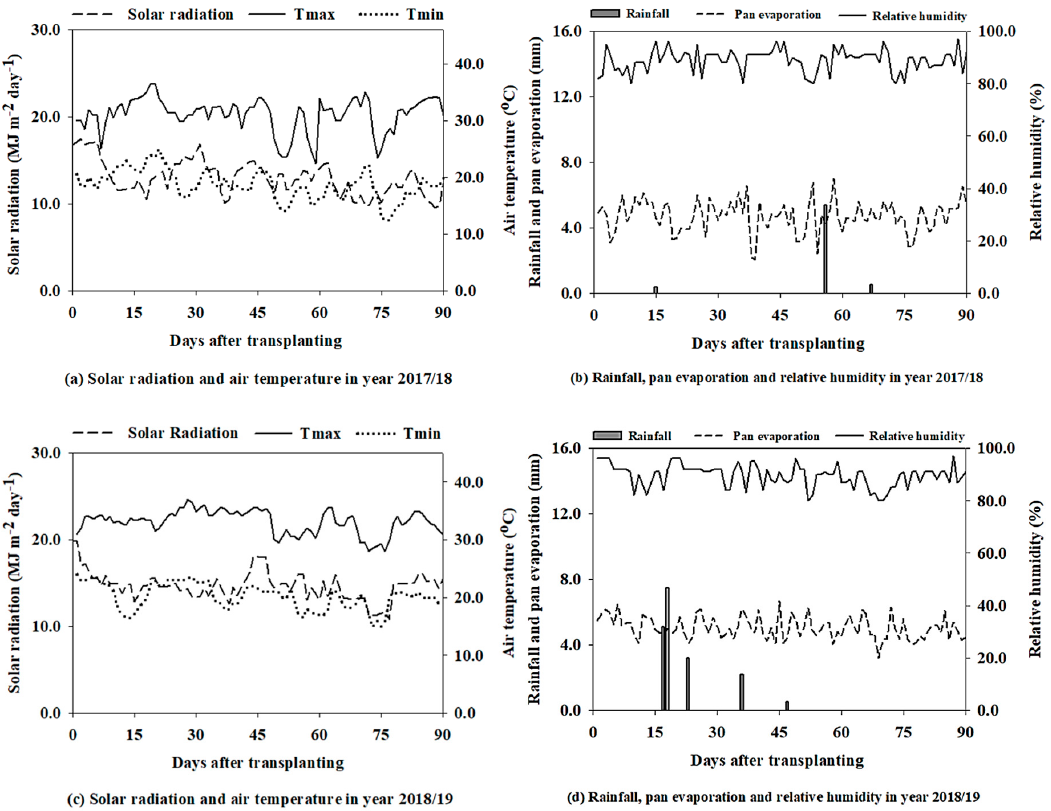
Figure 1. Solar radiation, maximum (Tmax) and minimum (Tmin) temperature in 2017/18 ( a ) and 2018/19 ( c ), rainfall, pan evaporation (Eo) and relative humidity (RH) in 2017/18 ( b ) and 2018/19 ( d ) at the meteorological station, Khon Kaen University, Thailand.